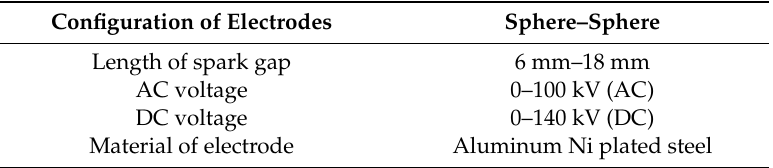
Table 6. Experimental constraints.